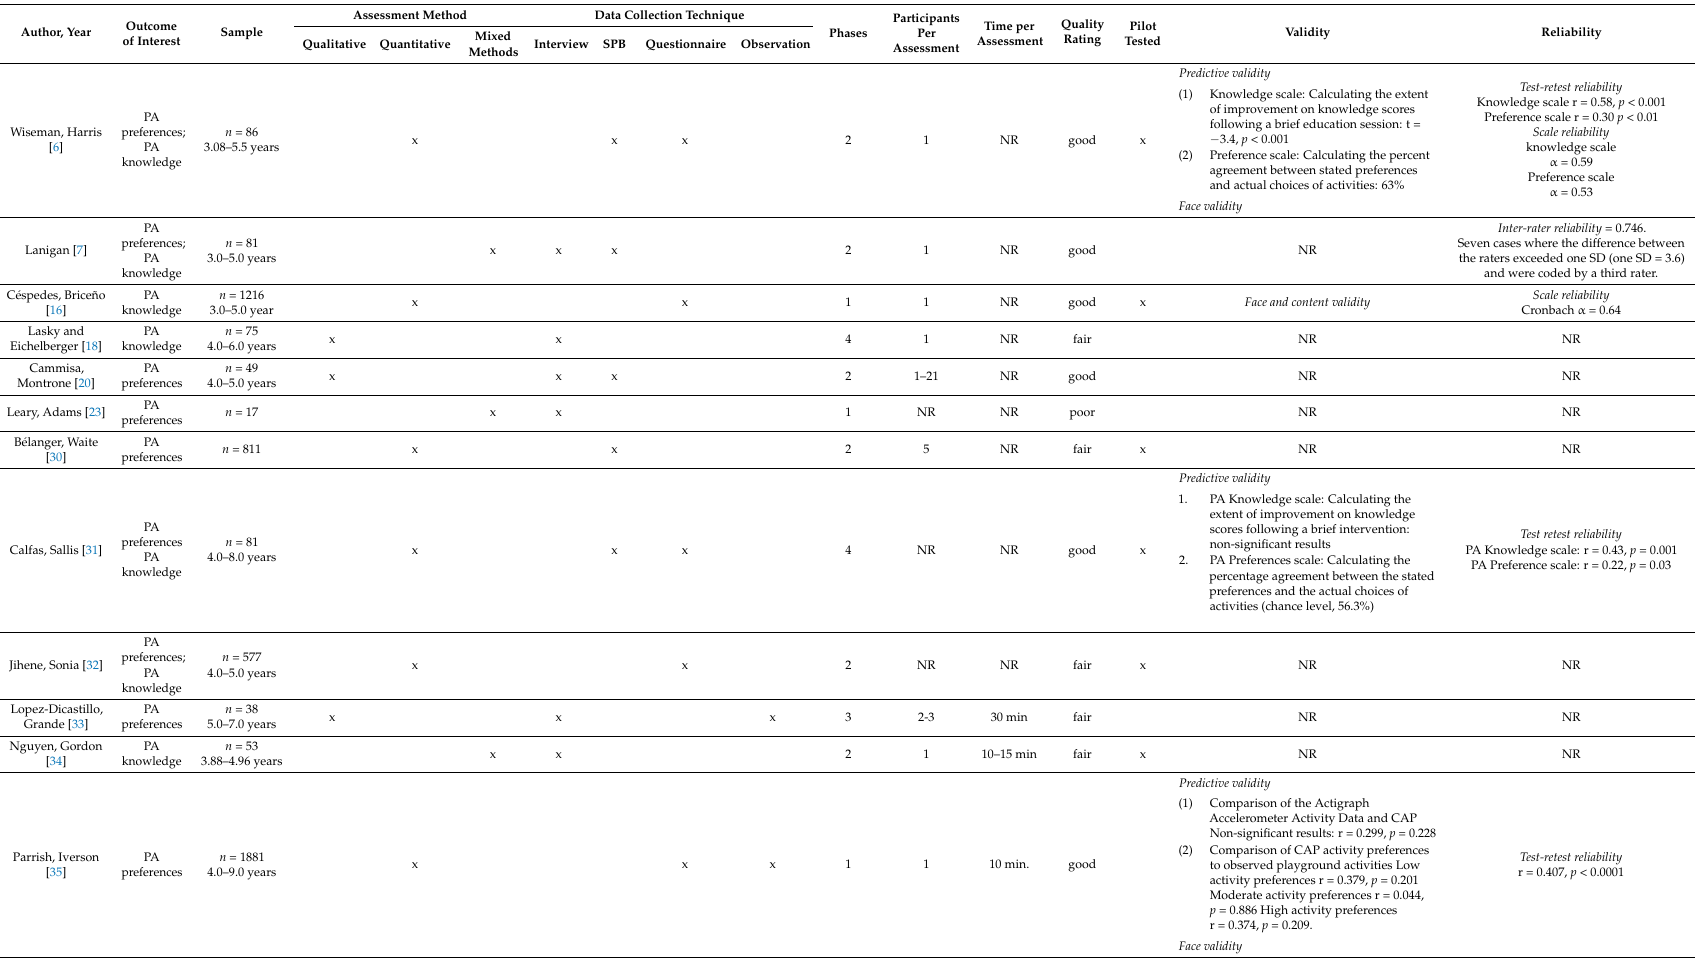
Table 1. Summary of data collection techniques used to assess preschool children’s knowledge of and preference for physical